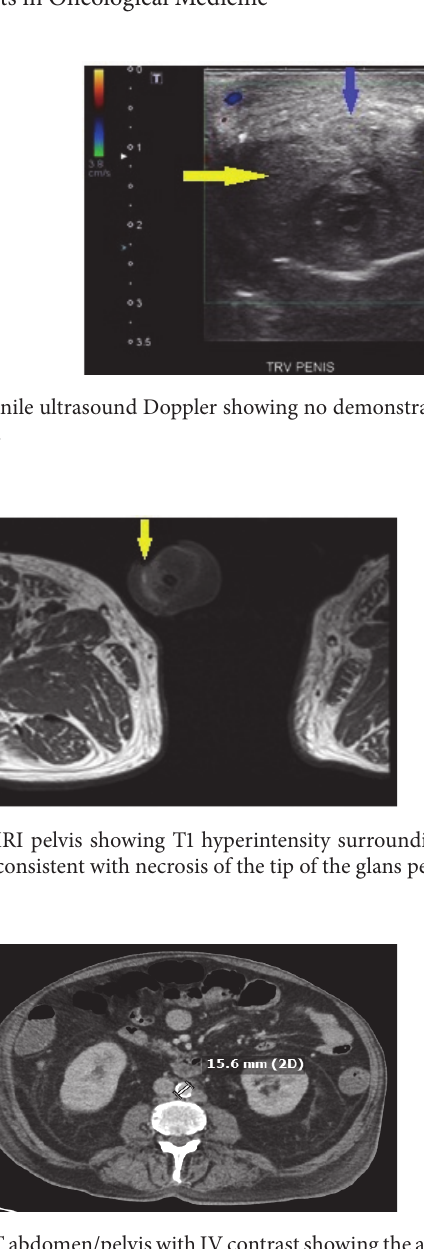
Figure 4: CT abdomen/pelvis with IV contrast showing the abdom- inal aorta measuring 15.6 mm at narrowest